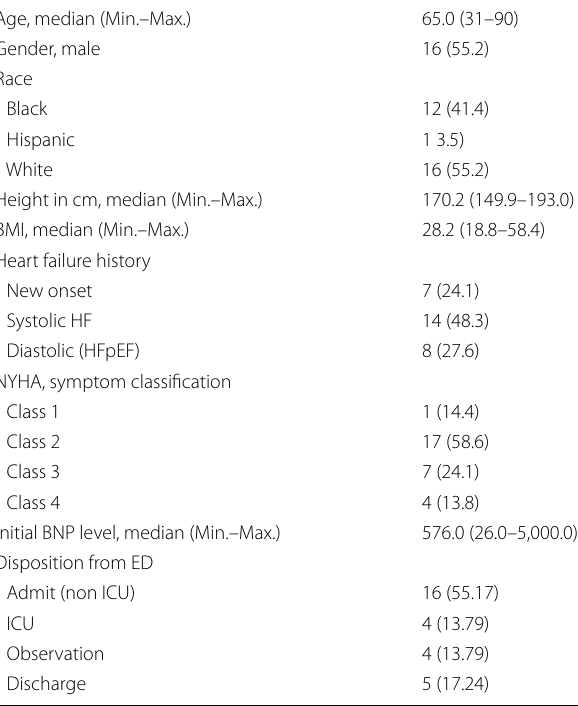
Age, median (Min.–Max.)